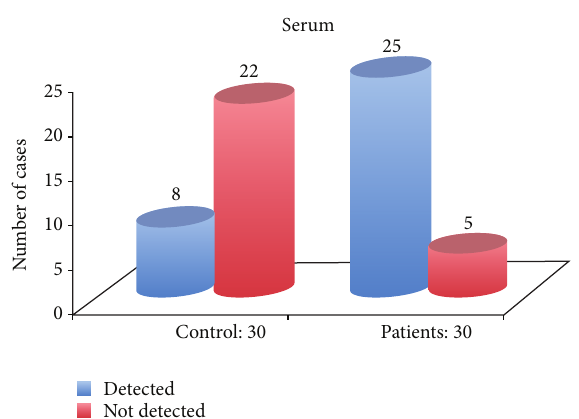
Figure 1: Proportion of detectability in saliva of Group A and Group B. Figure 2: Proportion of detectability in serum of Group A and